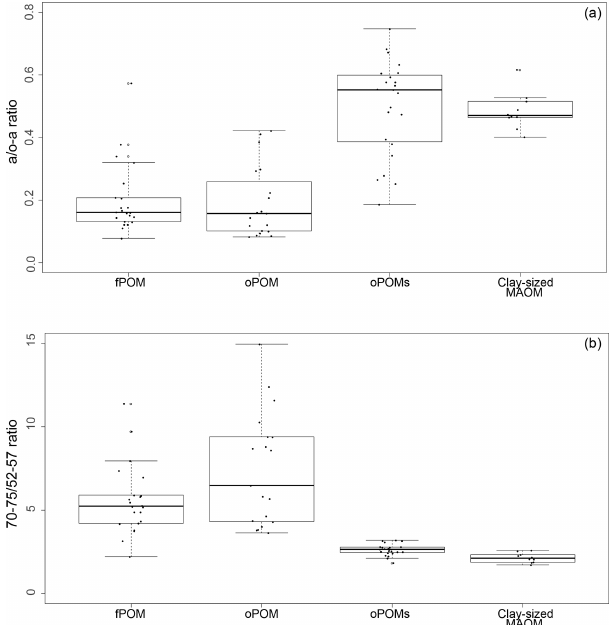
Figure 6. Decomposition proxies obtained by 13 C CP-MAS NMR spectroscopy for specific SOM fractions: both the a / o-a ratio (a) and 70–75 / 52–57 ratio (b) of SOM fractions demonstrate the sim- ilarity of large particulate OM fractions – free and occluded POM (fPOM and oPOM) – and the conjunctive characteristics of the small occluded particulate OM (oPOMs) fractions that links large POM fractions and the clay-sized MAOM fraction.